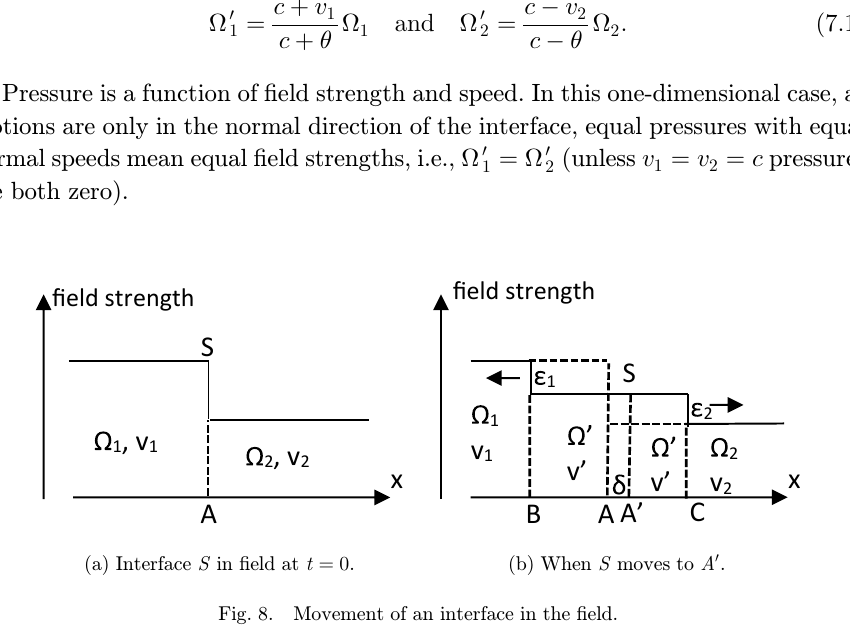
Fig. 8. Movement of an interface in the